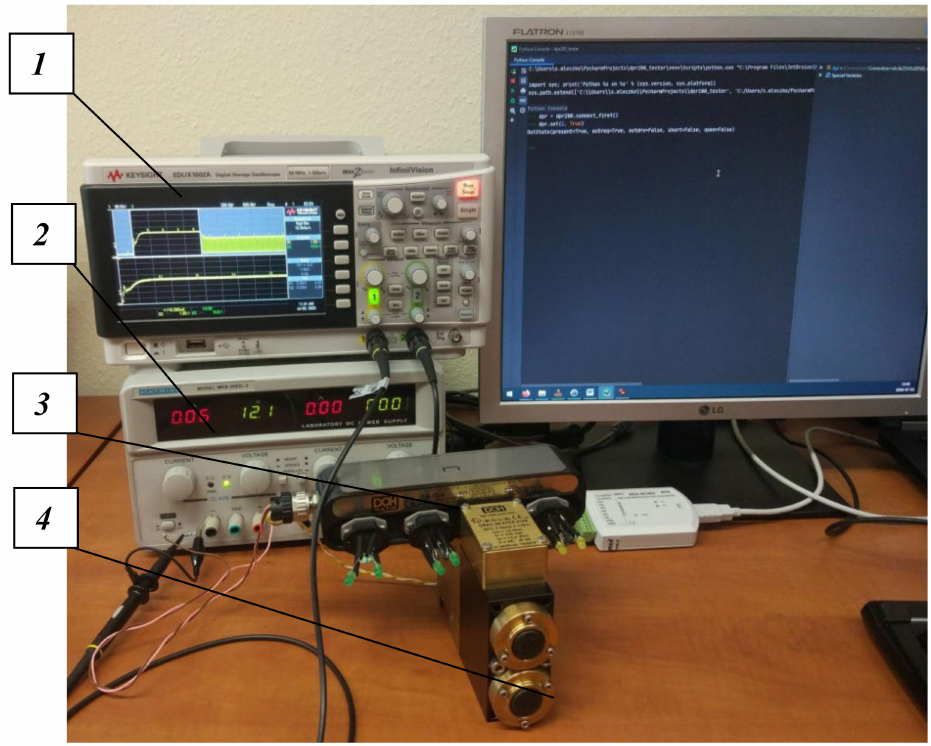
Figure 6. Test monitoring equipment, where 1—oscilloscope, 2—laboratory power supply, 3— controller module, and 4—solenoid